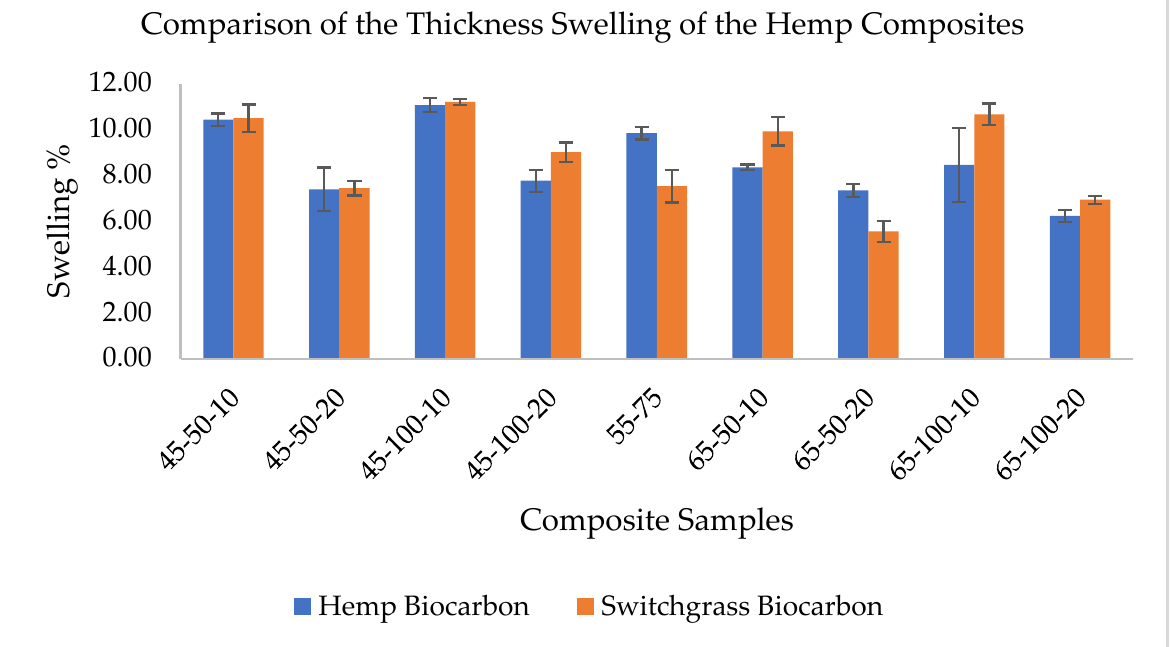
Figure 9. Thickness swelling of hemp reinforced composite samples with and without biocarbon filler.